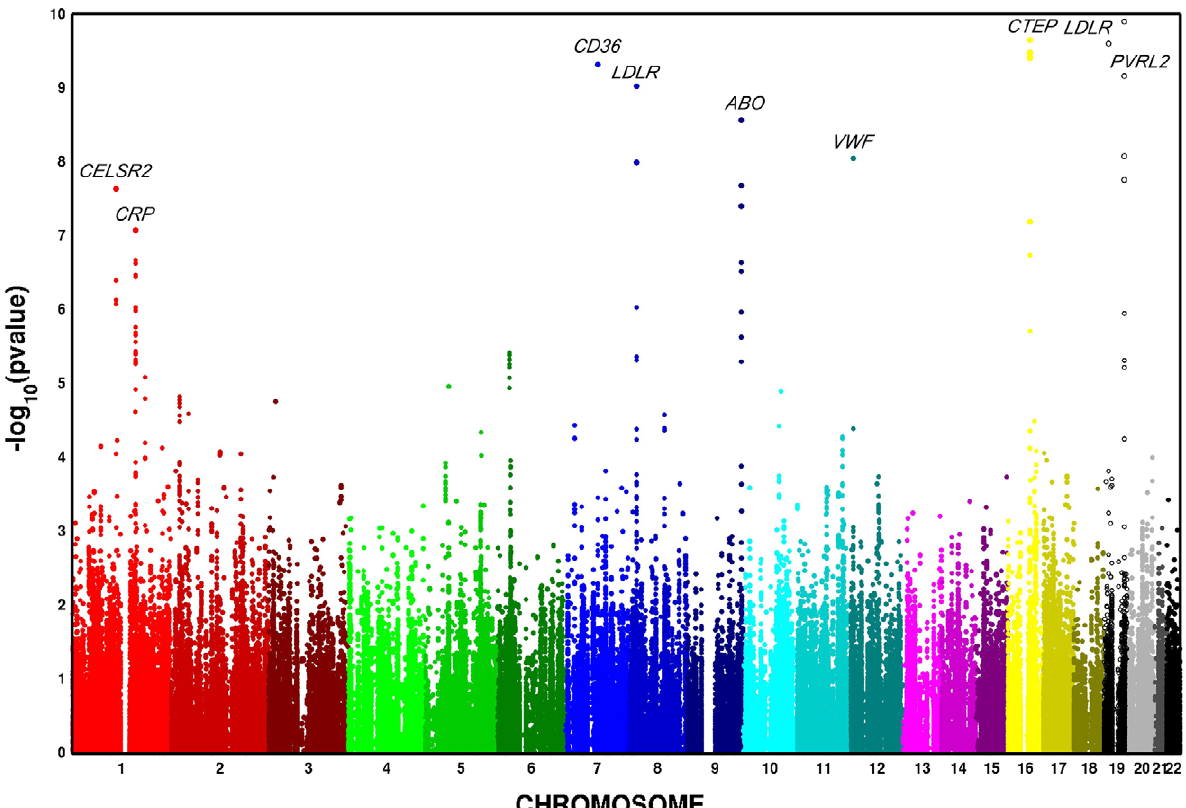
Figure 3. Multivariate GWAS of metabolic syndrome in n=6,287 African American participants from four cohorts. Y-axis P –values are truncated at 1 6 10 2 20 .